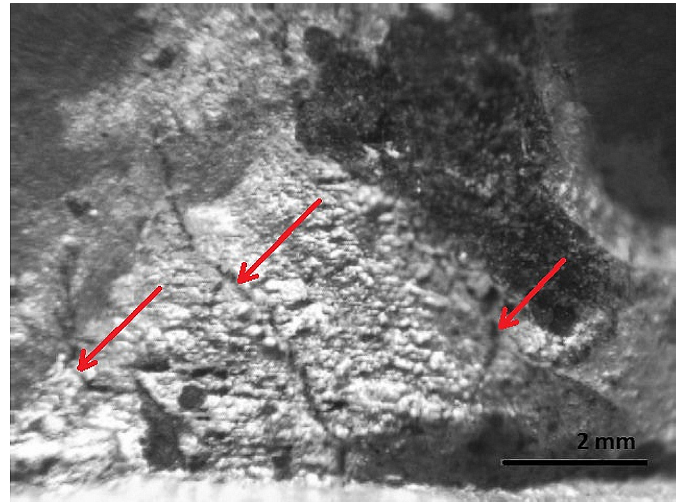
Figure 16. Fracture area: the area of the focal point of decay.